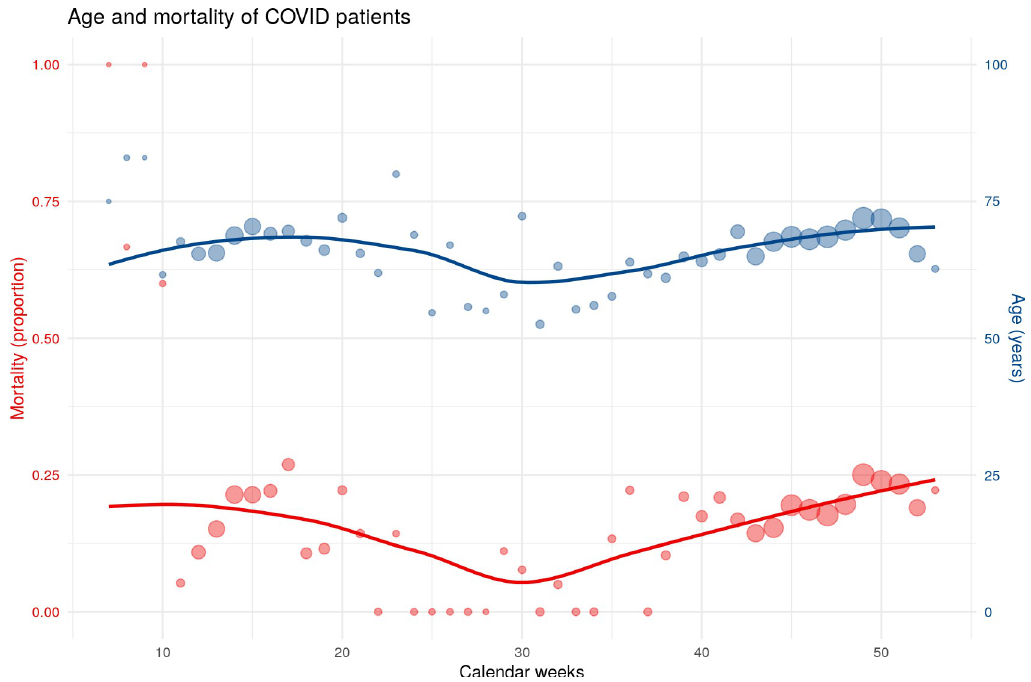
Fig 4. Temporal trend of mortality and age during the year 2020, based on the total study cohort (n = 4704). Dot size: small = up to 20 cases, medium = 21–40 cases, big = 41–60 cases.